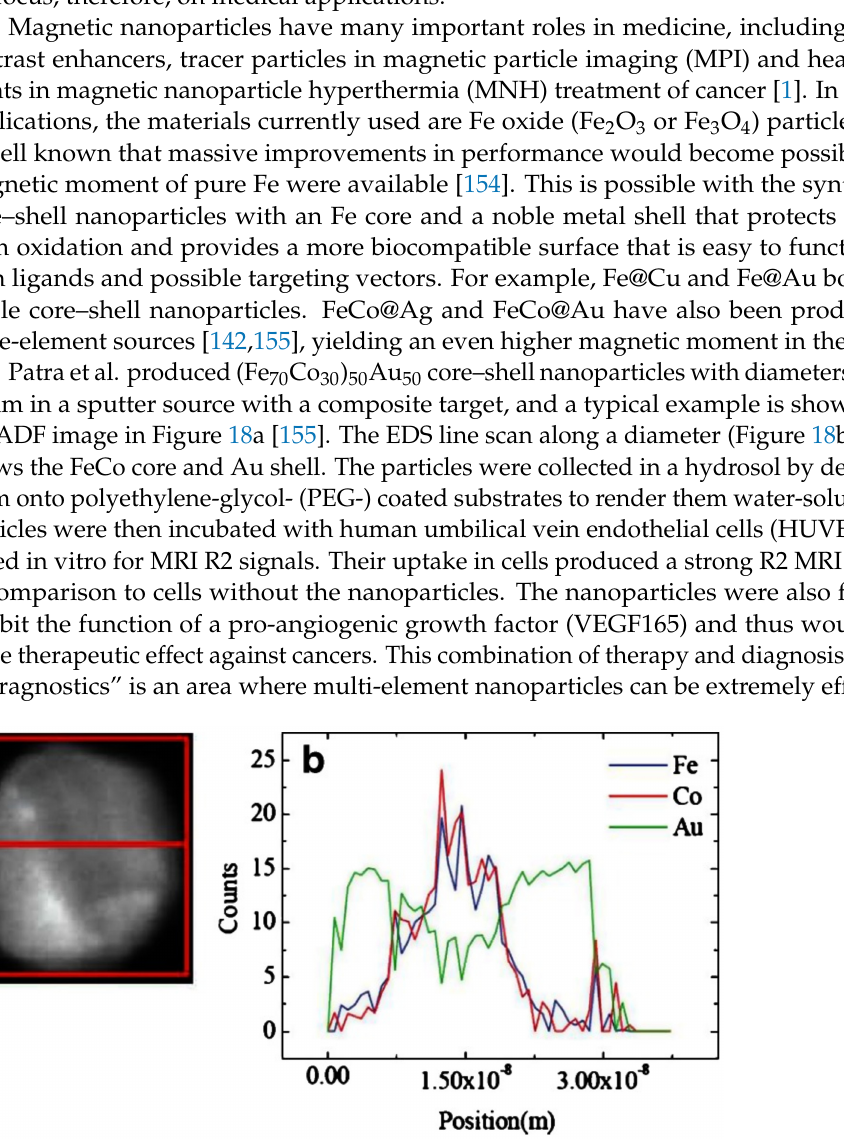
Figure 18. ( a ) HAADF image of a (FeCo)@Au nanoparticle used in an MRI study. ( b ) EDS line scan along the red line in a demonstrating the FeCo core and Au shell. Reproduced from